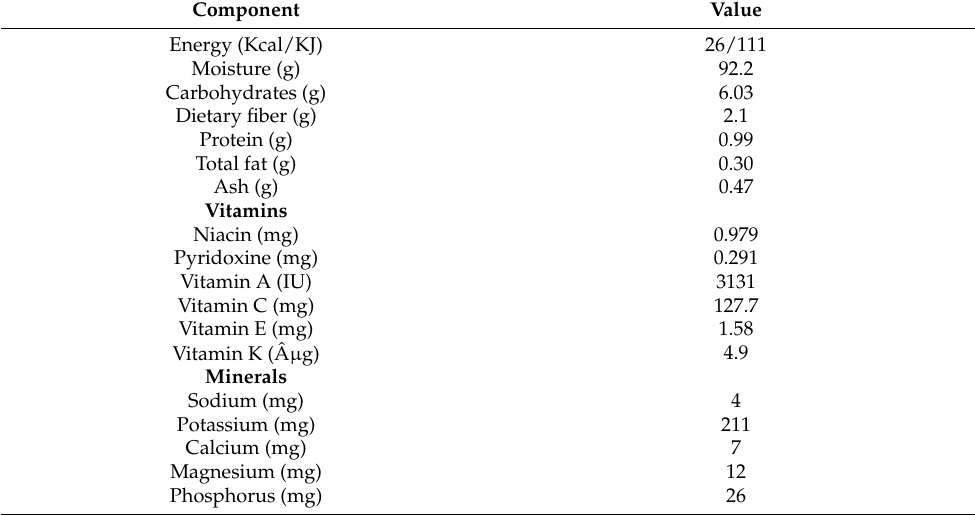
Table 1. Principal nutrient content by 100 g of bell pepper ( C. annuum var. annuum